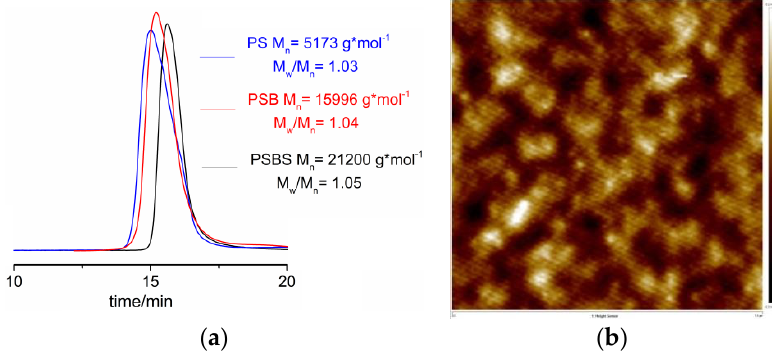
Figure 5. ( a ) The GPC data of polystyrene, polystyrene- b -polybutadiene and polystyrene- b -polybutadiene- b -polystyrene;( b ) AFM data of HO – SBS – OH. Table 2. Molecular weight data of every polymerization step.